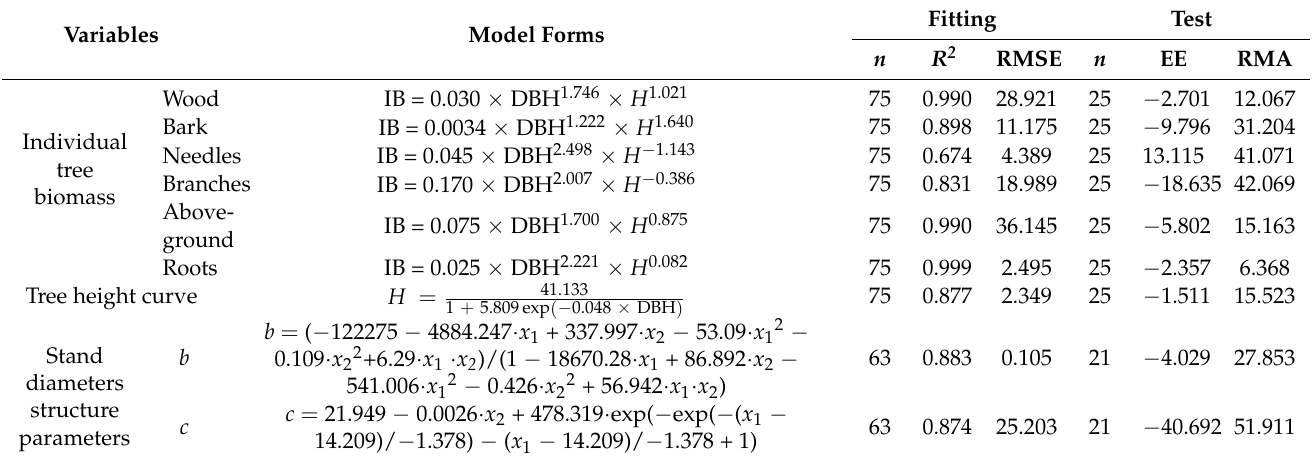
Table 7. The estimation result of the IB+SDS. IB is the individual tree biomass of each component (wood, bark, needles, branches), above-ground, and root individual tree biomass. DBH is the diameter at breast height, H is the value corresponding to DBH on the tree height curve, b and c are the stand diameter structure parameters, x 1 represents the AGE of the stand age, and x 2 represents the stand density.